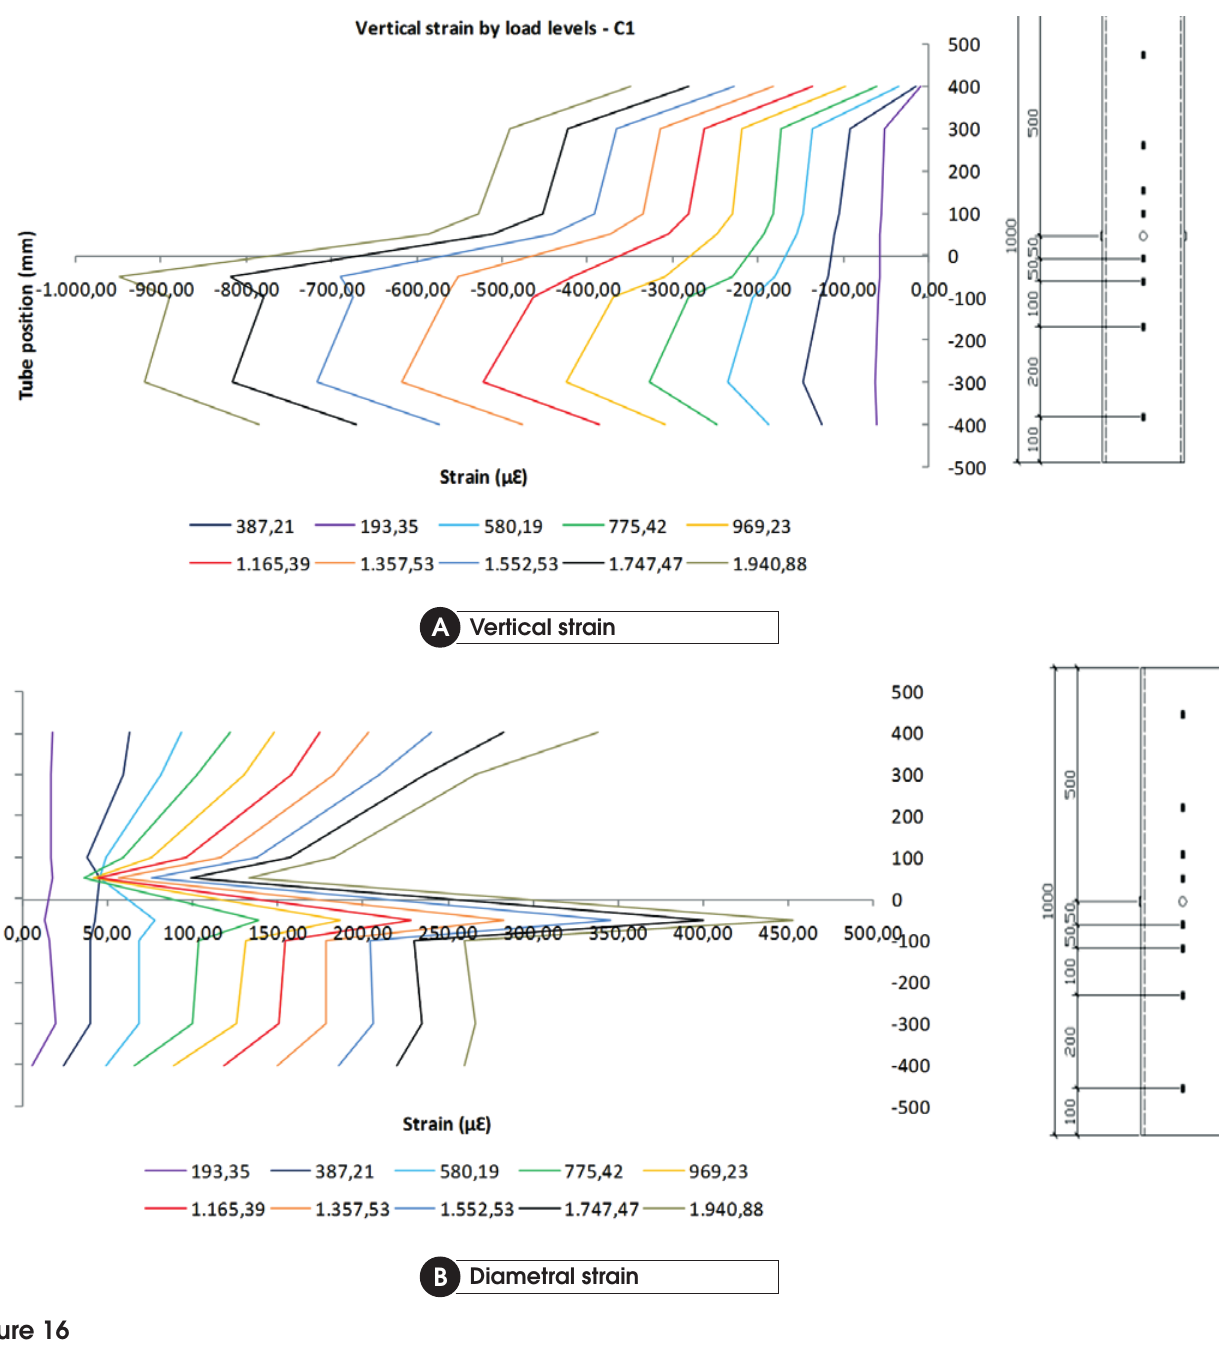
Figure 16 Distribution curves of the strains along the tube - C1-15.1-3/4-SF-21,7